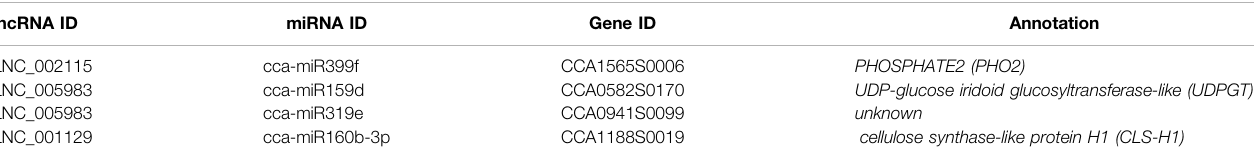
TABLE 2 | CeRNA network and its target gene annotation in